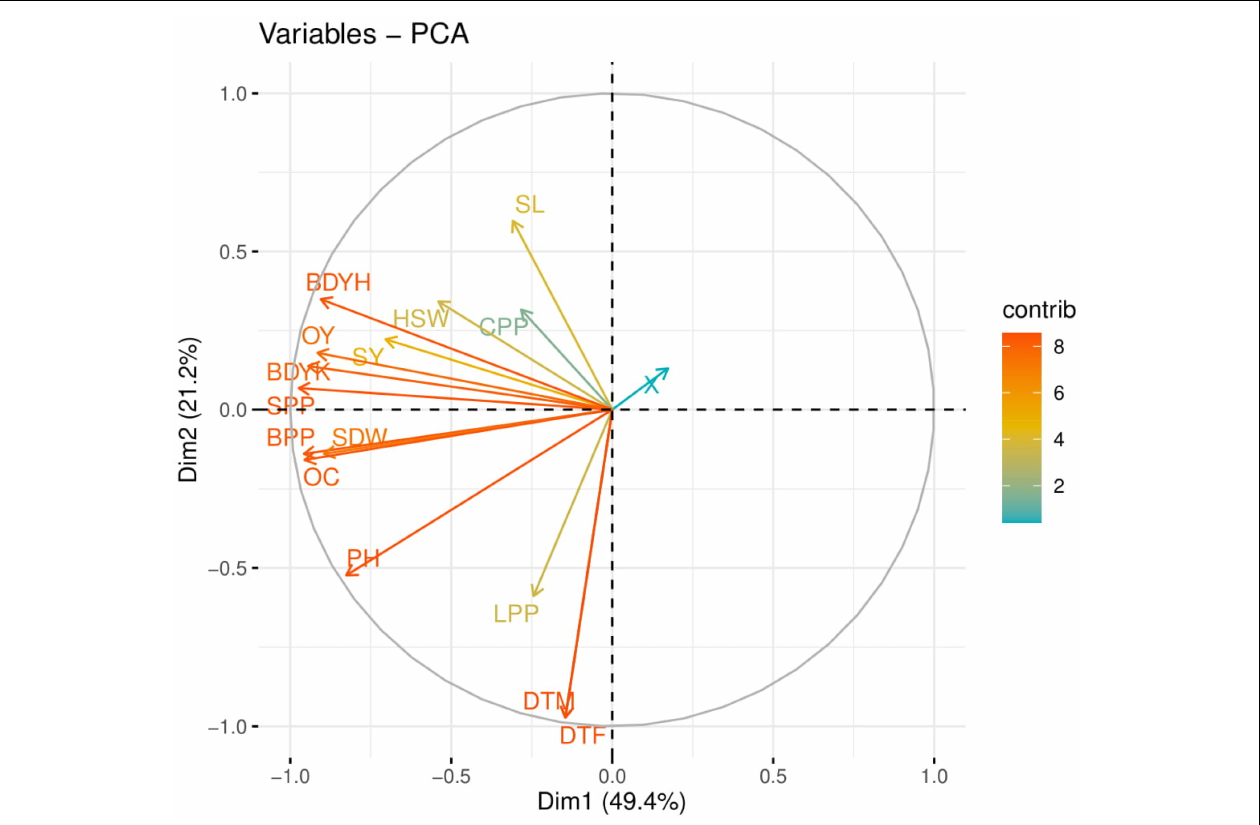
FIGURE 4 | Loading plots of principal component analysis (PCA) on different studied attributes of caster bean varieties under different fertilizations of S in the soil. Different abbreviations used in this figure are as follows: PH, plant height; SL, spike length; BPP, branches per plant; SPP, spike per plant; SDW, spike dry weight; DTF, days taken to 50% flowering; CPP, capsule per plant; HSW, hundred seed weight; SY, seed yield; DTM, days taken to maturity; OC, oil content; OY, oil yield; BDY, biodiesel